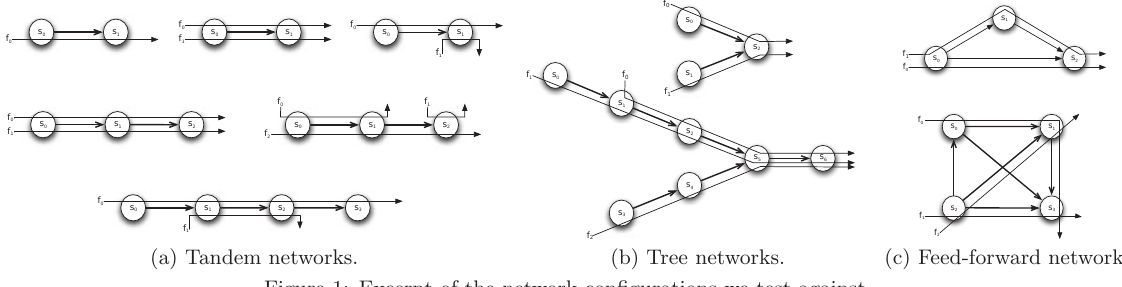
Figure 1: Excerpt of the network configurations we test